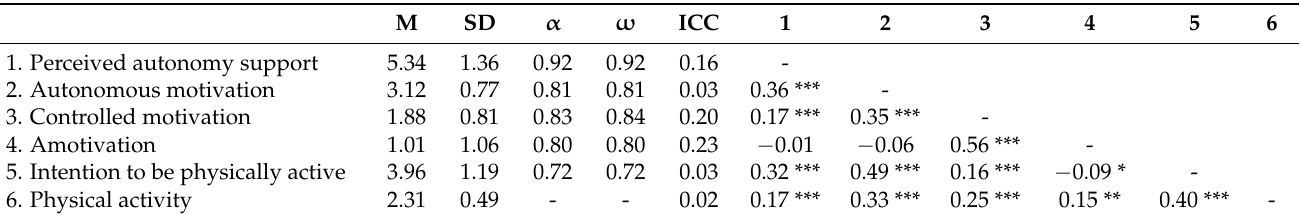
Table 1. Means, standards deviations, bivariate correlations, and reliability analysis of the